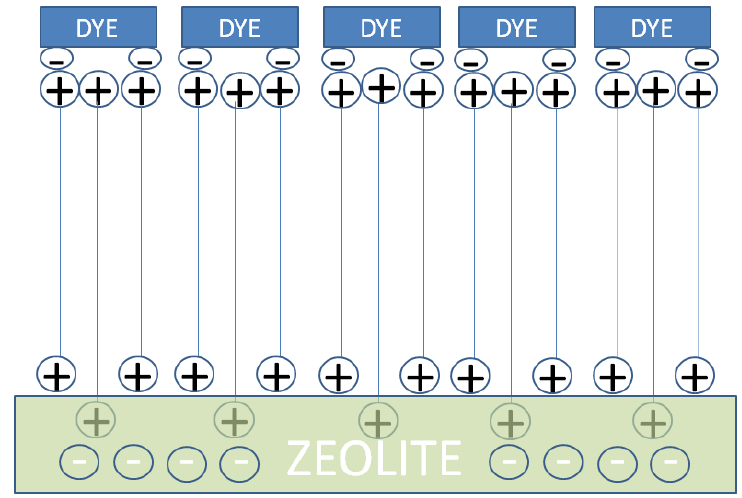
Figure 4. Zeolite adsorption of dye.